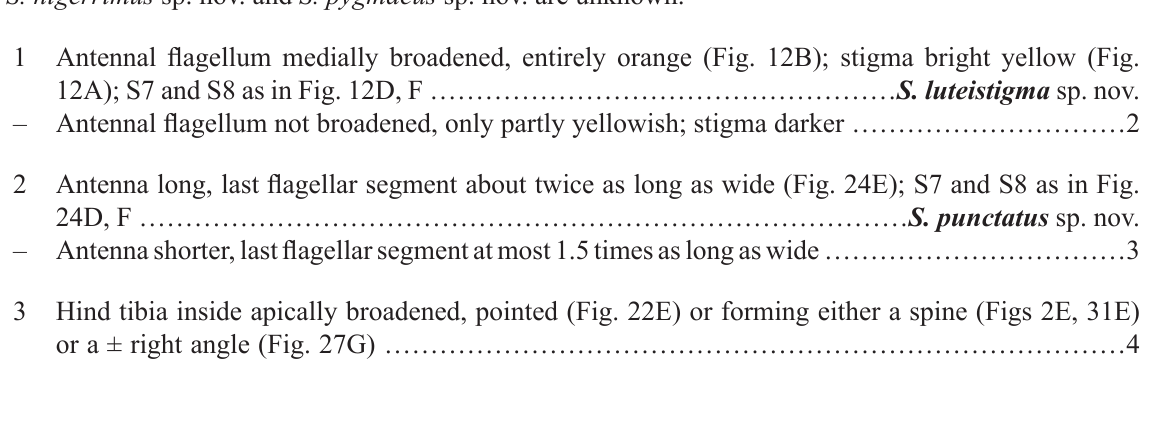
– Metasomal terga either impunctate or with more dispersed/coarser punctation; if punctation is similar (some specimens of S. punctatus sp. nov.) then terga at least basally with superficial sculpture and 10 Metasomal terga impunctate (Figs 19E, 25E); scutum distinctly reticulate and shallowly punctate (Figs 19B, 25C–D) ………………………………………………………………………………11 – Metasomal terga punctate, sometimes punctures minute (Fig. 26E); scutum either without 11 Basal area of propodeum distinctly and largely carinate (Fig. 19B) …… S. nigritarsis sp. nov. – Basal area of propodeum along anterior margin indistinctly carinate (Fig. 25C–D) ……………… 12 Scutum covered with large punctures (Figs 23C–D, 30C–D) …………………………………13 – Scutum covered with smaller punctures (Figs 14E–F, 15C–D, 16E–F, 21C–F, 26C–D) ………14 13 Basal area of propodeum shorter, medially only slightly longer than metanotum; few, short and indistinct carinae (Fig. 23C–D) ……………………………………………… S. punctatus sp. nov. – Basal area of propodeum longer, medially about 1.5 times as long as metanotum; carinae longer and more distinct than in S. punctatus (Fig. 30C–D) ……………………………… S. spinipes sp. nov. 14 Punctation of metasomal terga minute, almost invisible (Fig. 26E) ……… S. roggeveldi sp. nov. – Punctation of metasomal terga much coarser and clearly visible (Figs 14B, 15E, 16B, 21G–H) …15 15 Head distinctly broader than long (Figs 14C–D, 16C–D) ………………………………………16 – Head about as long as broad (Figs 15B, 21B) …………………………………………………17 16 Clypeus, supraclypeal area and T1 mostly polished and shiny, only partially very finely and superficially sculptured, slightly matt (Fig. 14B–D) ……………………… S. minutuloides sp. nov. – Clypeus, supraclypeal area and T1 (particularly anteriorly) mostly finely sculptured and matt (Fig. 16B–D) …………………………………………………………………… S. nanus sp. nov. 17 Metanotum apically more evenly rounded, without distinct carinate depression (Fig. 15D); fore tibia anteriorly largely yellowish-brown …………………………… S. minutus sp. nov. – Metanotum apically with a carinate depression (Fig. 21D, F); fore tibia anteriorly blackish, only at the base with a small yellowish spot ……………………………… S. papkuilsi sp. nov. Males The males of S. gessorum sp. nov., S. inexpectatus sp. nov., S. minutuloides sp. nov., S. minutus sp. nov., S. nigerrimus sp. nov. and S. pygmaeus sp. nov. are unknown. Antennal flagellum medially broadened, entirely orange (Fig. 12B); stigma bright yellow (Fig. 12A); S7 and S8 as in Fig. 12D, F …………………………………………… S. luteistigma sp. nov. – 2 Antenna long, last flagellar segment about twice as long as wide (Fig. 24E); S7 and S8 as in Fig. – Antenna shorter, last flagellar segment at most 1.5 times as long as wide ……………………………3 3 Hind tibia inside apically broadened, pointed (Fig. 22E) or forming either a spine (Figs 2E, 31E) or a ± right angle (Fig. 27G)